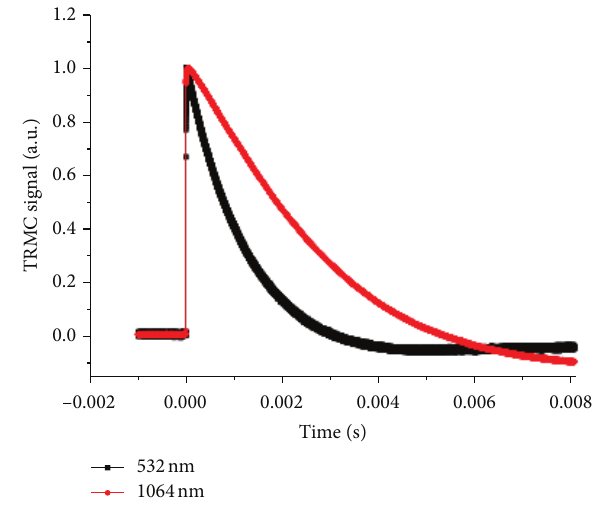
Figure 1: TRMC decay curves of sample with n a-Si:H on both sides induced by 532 and 1064nm.